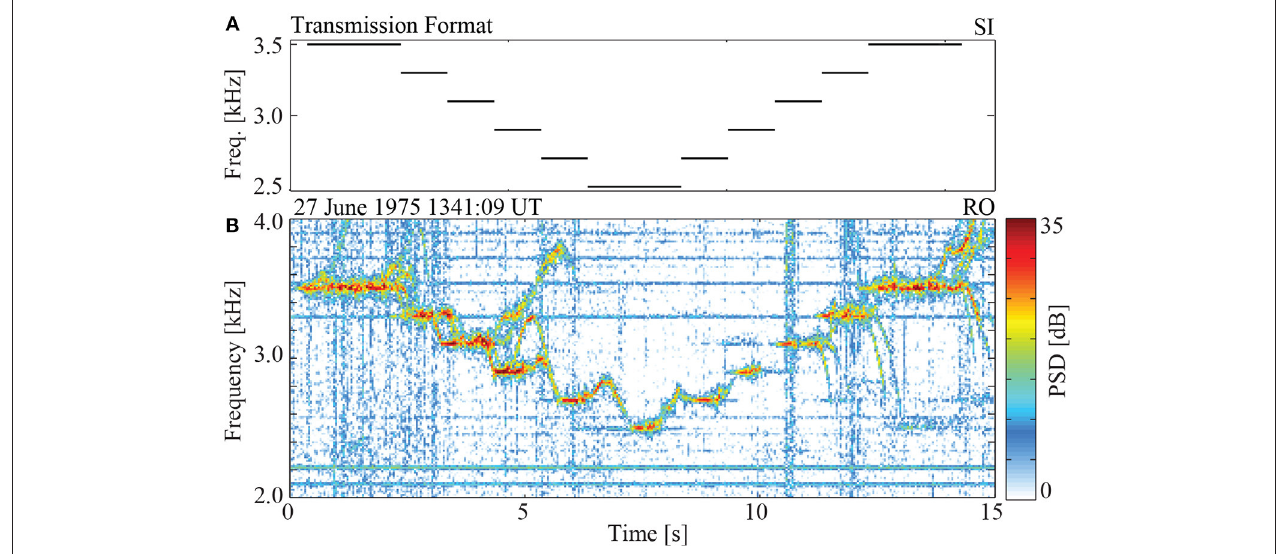
FIGURE 5 | A case of entrainment from the Siple Station experiment received at Roberval on 27 June 1975 at 13:41:09 UT, in which a “stair-step” transmission from Siple starting at 3.5kHz triggered a free-running plasma emission whose time-frequency characteristics are controlled by the subsequent constant frequency transmissions. (A) Time-frequency format transmitted by Siple. (B) Received signal at Roberval (magnetic conjugate point), showing characteristics of entrainment. Adapted from Figure 2.7 of Gibby